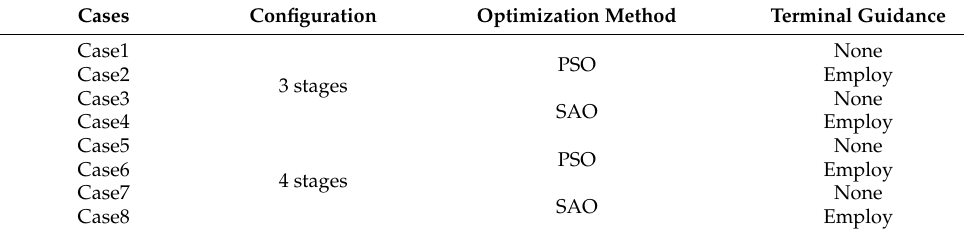
Table 5. Illustration of the eight design